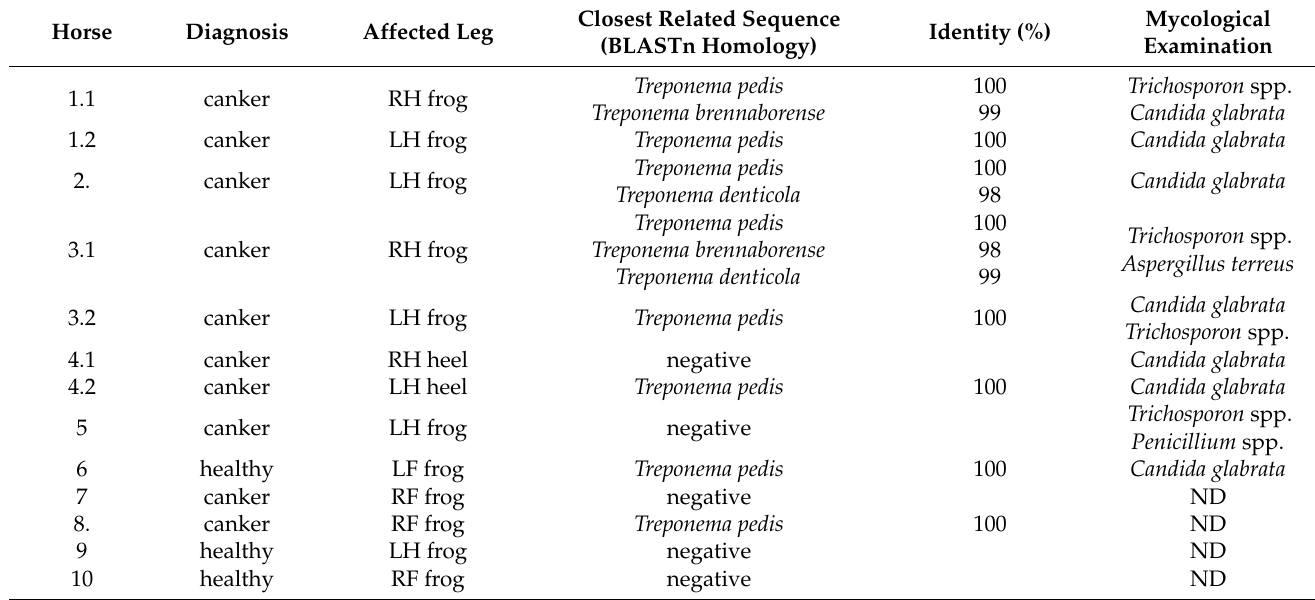
Table 4. Treponema spp. detection and mycological examination results of equine hoof biopsies.